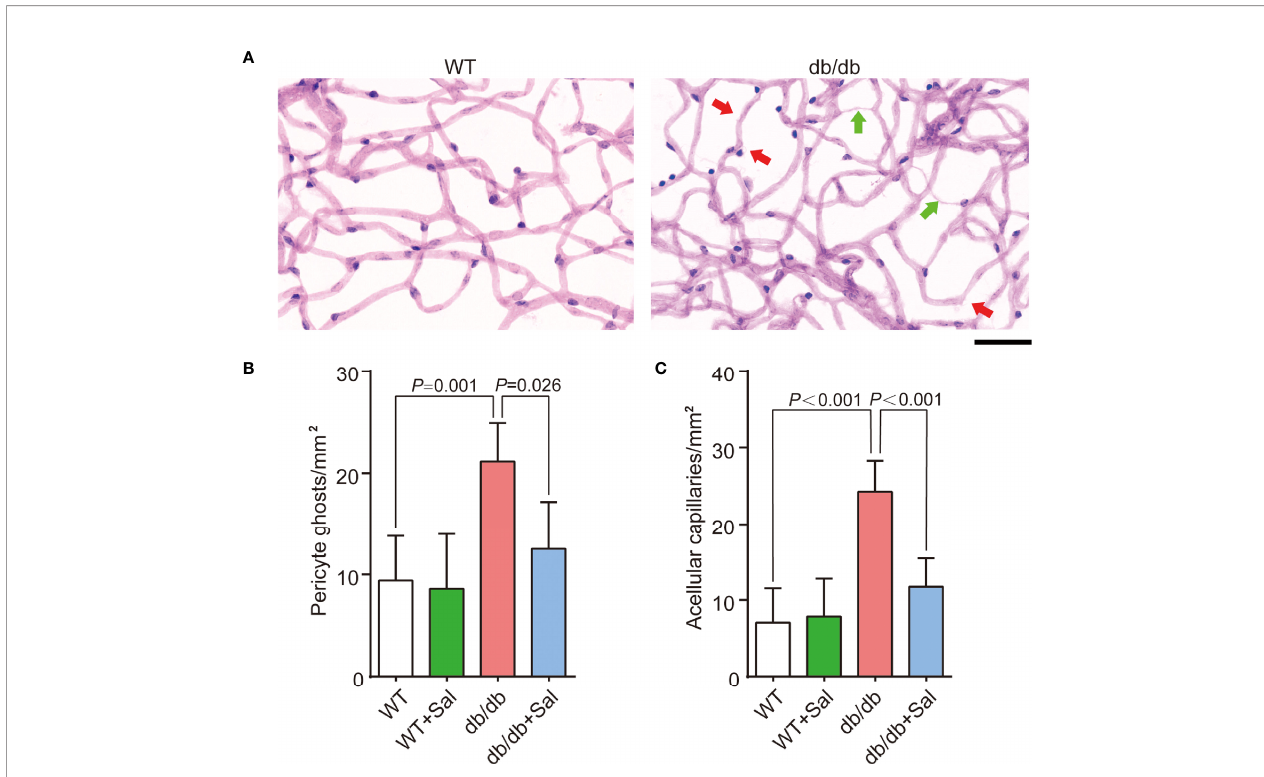
FIGURE 2 | Sal alleviated retinal microvascular changes in db/db mice. (A) The representative photomicrographs of normal and diabetic microvessel stained by Schiff ’ s reagent and hematoxylin; The green arrows pointed is acellular capillaries, and the red arrows pointed is pericyte ghost. (B) The number of pericyte ghost in WT and db/ db mice after Sal intervention. (C) The number of acellular capillaries in WT and db/db mice after Sal intervention. Data are the mean ± SD. Scale bar = 50 m